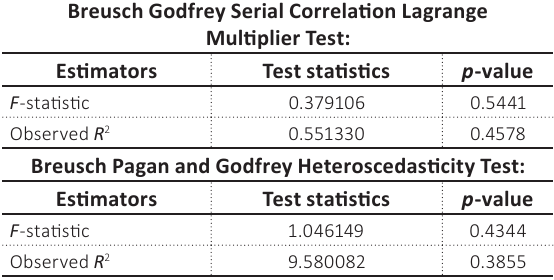
Table 7. Diagnostic